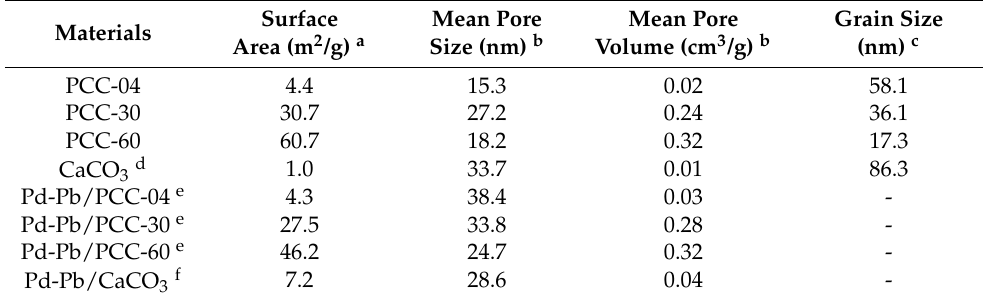
Table 1. The comparison of physical parameters between our PCC supports and catalysts vis- à -vis their commercial